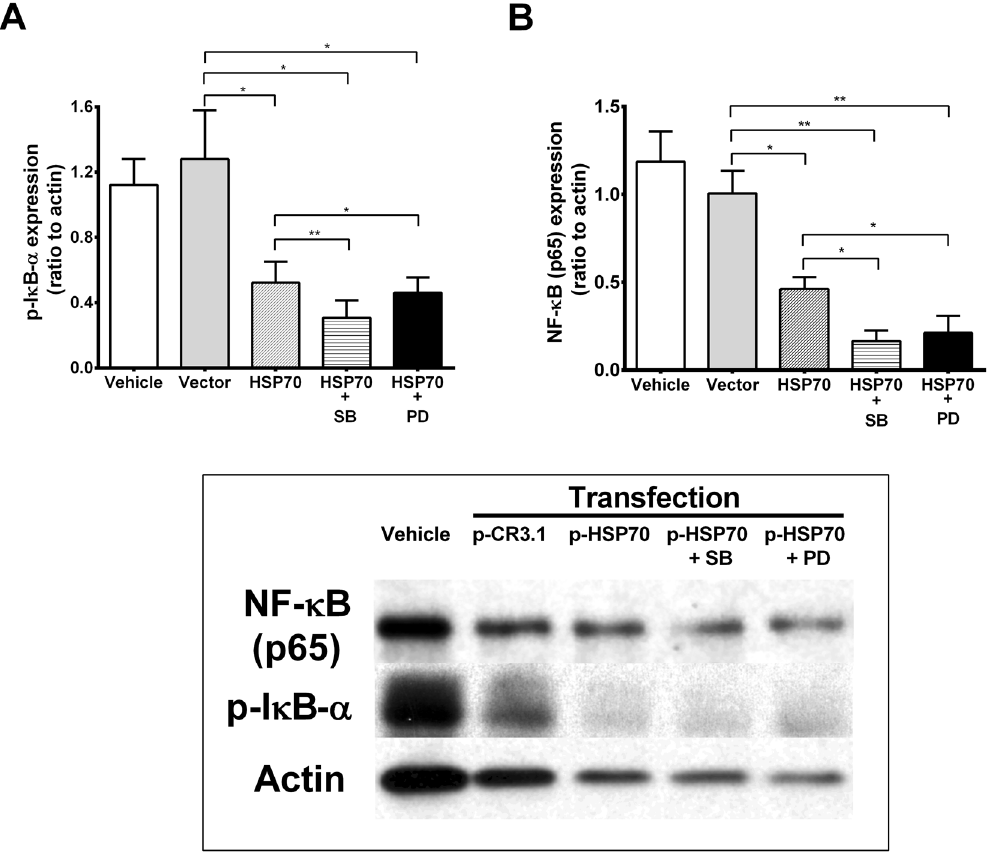
Figure 2. Western blot analysis to quantify the expression of I κ B- α ( A ) and NF- κ B p65 activation ( B ) in HSP70 overexpression (HSP70) of alveolar macrophages derived from TB patients (n = 5) in the absence or presence of a p38 kinase (SB) or ERK kinase inhibitor (PD). ** p < 0.01, * p < 0.05 compared with vector transfection control